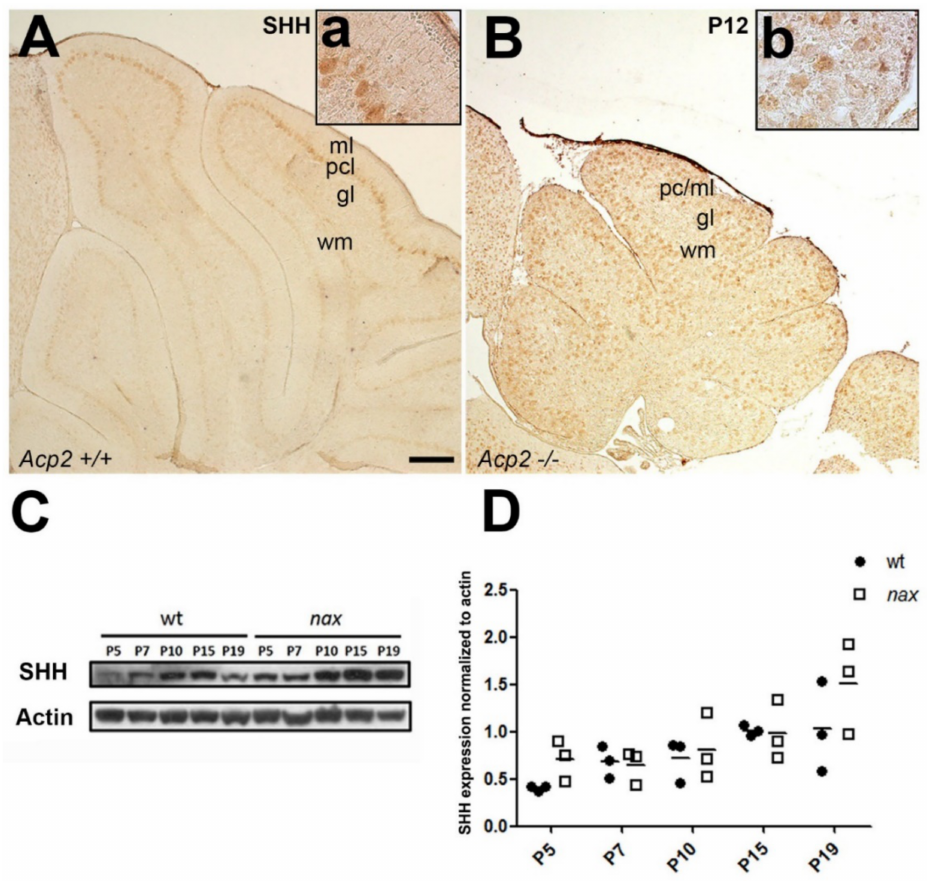
Figure 5. SHH is expressed to a similar extent by cerebellar PCs in wt and nax mutant mice. ( A , B ) Sagittal sections of P12 wt and nax mouse cerebella immunostained with SHH show that the expression of SHH is localized in PCs in both groups. ( C , D ) Western blot analysis of SHH expression at P5, -7, -10, -15 and -19 reveals a modest increase over time and similar expression levels in wt and nax cerebella at all time-points (wt: n = 3 and nax : n = 3). The actin shows consistent and equal loading of all cerebellar samples. The data in the graph are presented as the mean ± SEM, and statistical analysis was performed using one-way ANOVA. Abbreviations: gl, GC layer; ML, molecular layer; PCL, PC layer; wm, white matter. Scale bars: 100 µ m in ( A ) applies to ( A , B ). SHH signaling is regulated by multiple mechanisms and interactions with various proteins [46]. Extracellularly, the SHH signaling response and distribution are regulated by HHIP, CDON (Codon), BOC (Brother of Codon), and GAS1, which dynamically interact with the Patched 1 (receptor), leading to the controlled release of SMO inhibition [46]. RT- qPCR showed that Hhip gene expression in the nax cerebellum was comparable to control